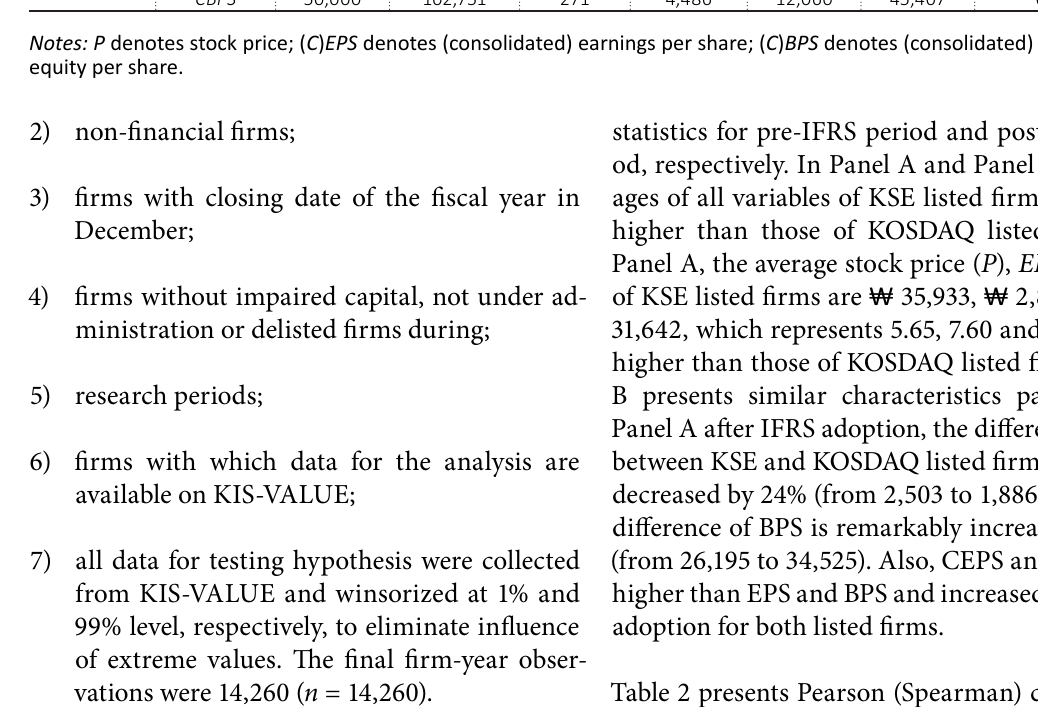
Table 1. Descriptive statistics ( n = 14,260)